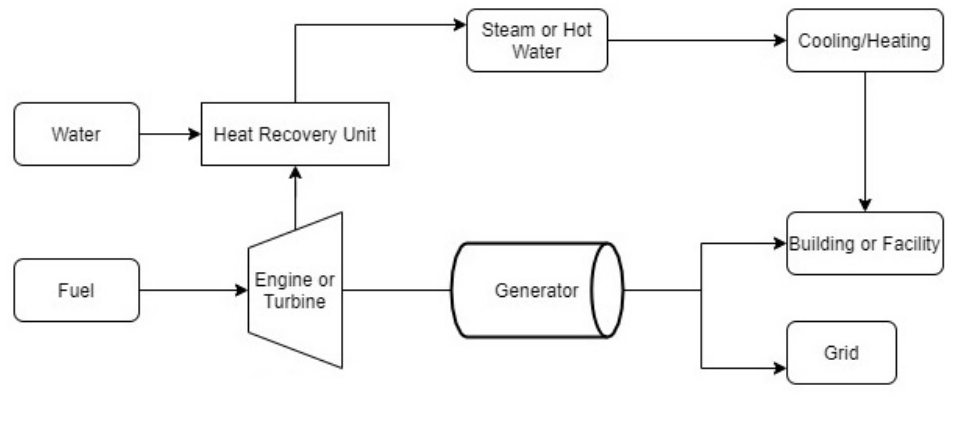
Figure 1. Heat Recovery Steam Generation—One of the configurations of operation of CHP units.